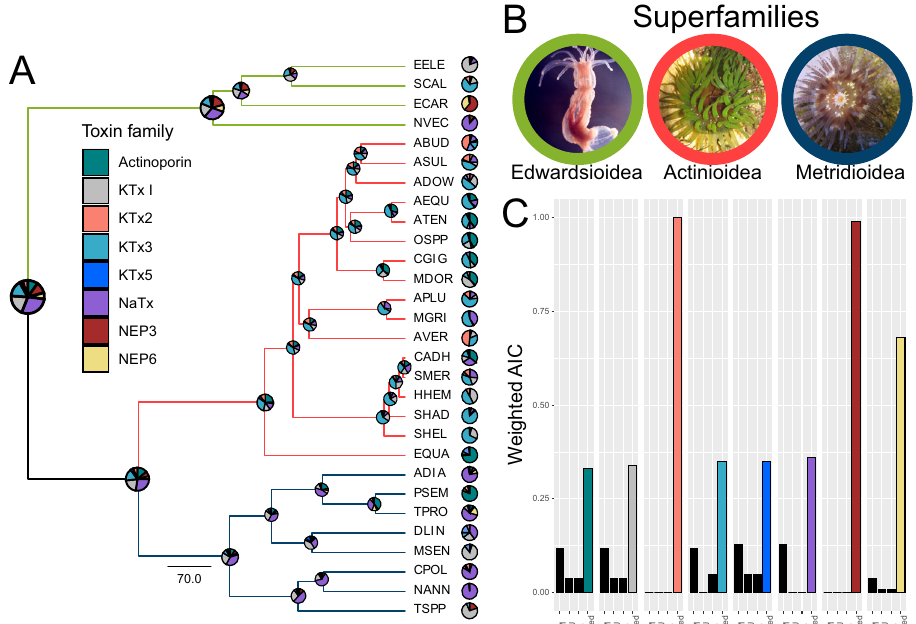
Fig. 1 | Ancestral reconstruction and phylogenetic constraints on the venom expressionphenotypeinActiniaria.A Phylogenetictreeofseaanemoneswithpie chartsnodesrepresentstheancestralreconstructionofknowntoxinsandpiechart at tips represents the venom expression phenotype. All nodes had ultrafast boot- strap support >95% at nodes. B Representative images of the three sea anemone superfamilies included in the phylotranscriptomic analyses (Edwardsioidea —